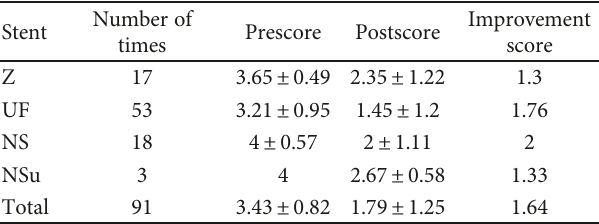
Table 2: Patient and tumor characteristics. Table 3: Improvement in the dysphagia score (mean ±